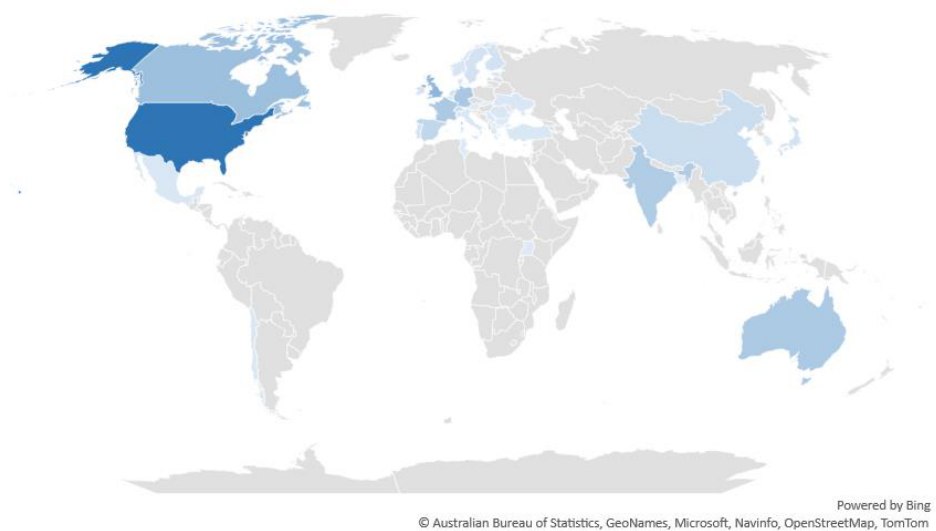
Figure 9. AI-based companies in the power sector across the Globe.